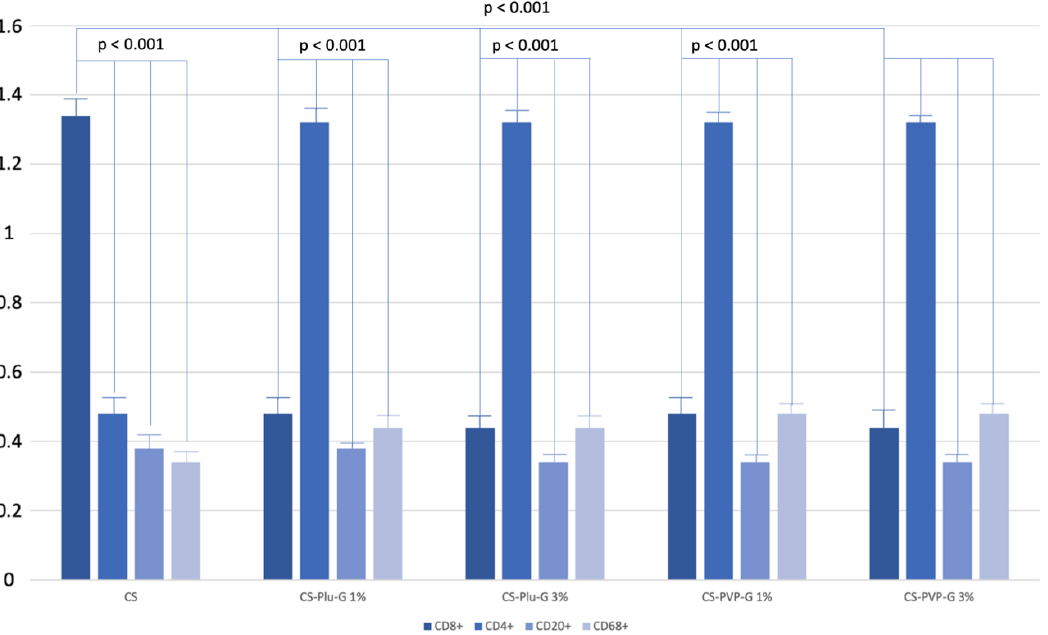
Figure 8. Polymerase chain reaction results to detect expression activity of CD8+, CD4+, CD20+ and CD68+ markers in CS, CS-Plu-G 1%, CS-Plu-G 3%, CS-PVP-G 1% and CS-PVP-G 3% sample groups.